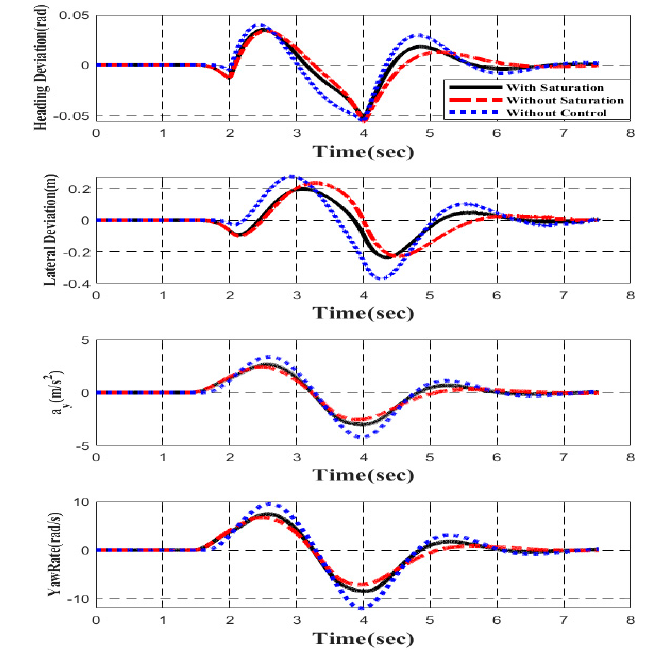
Figure 4. The simulation results for the heading angle deviation, lateral deviation, lateral acceleration, and yaw rate.